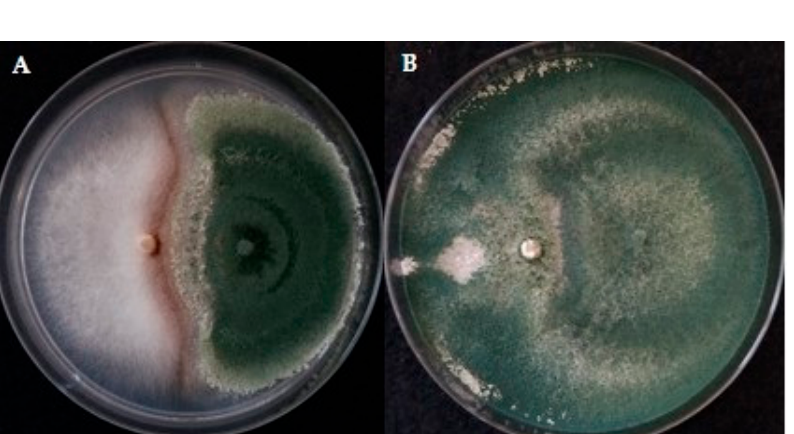
Figure 2. In vitro confrontation of Lentinula edodes (left) and Trichoderma isolates (right). ( A ) T. gui- zhouense SZMC 25749, ( B ) T. simmonsii SZMC 24248. SZMC 25749, ( B ) T. simmonsii SZMC